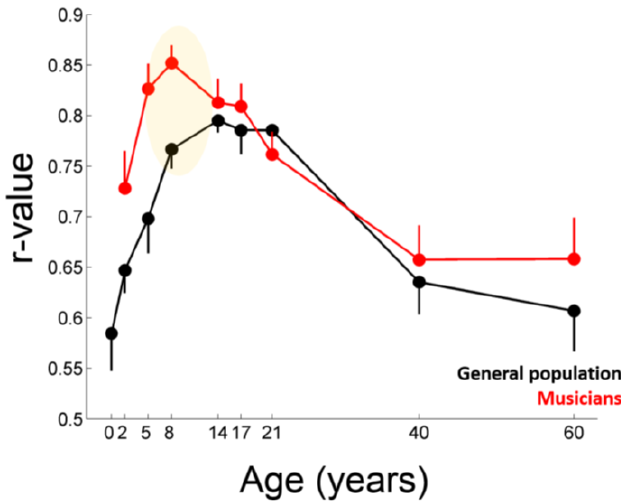
Figure 3. Developmental processes constrain how much the auditory environment can influence auditory function. As shown here for the auditory brainstem response to speech, the stability of the response ( i.e. , within-test repeatability of the response) has a different developmental trajectory in musically trained individuals ( red ) compared to the general population ( i.e. , individuals with no to minimal training) ( black ). Notably the group differences are largest early in life (before age 10) when the developmental trajectory is most in flux. Error bars represent one SEM. The value reported on the x-axis represents the youngest age for each group of participants. Modified from Skoe and Kraus, 2013